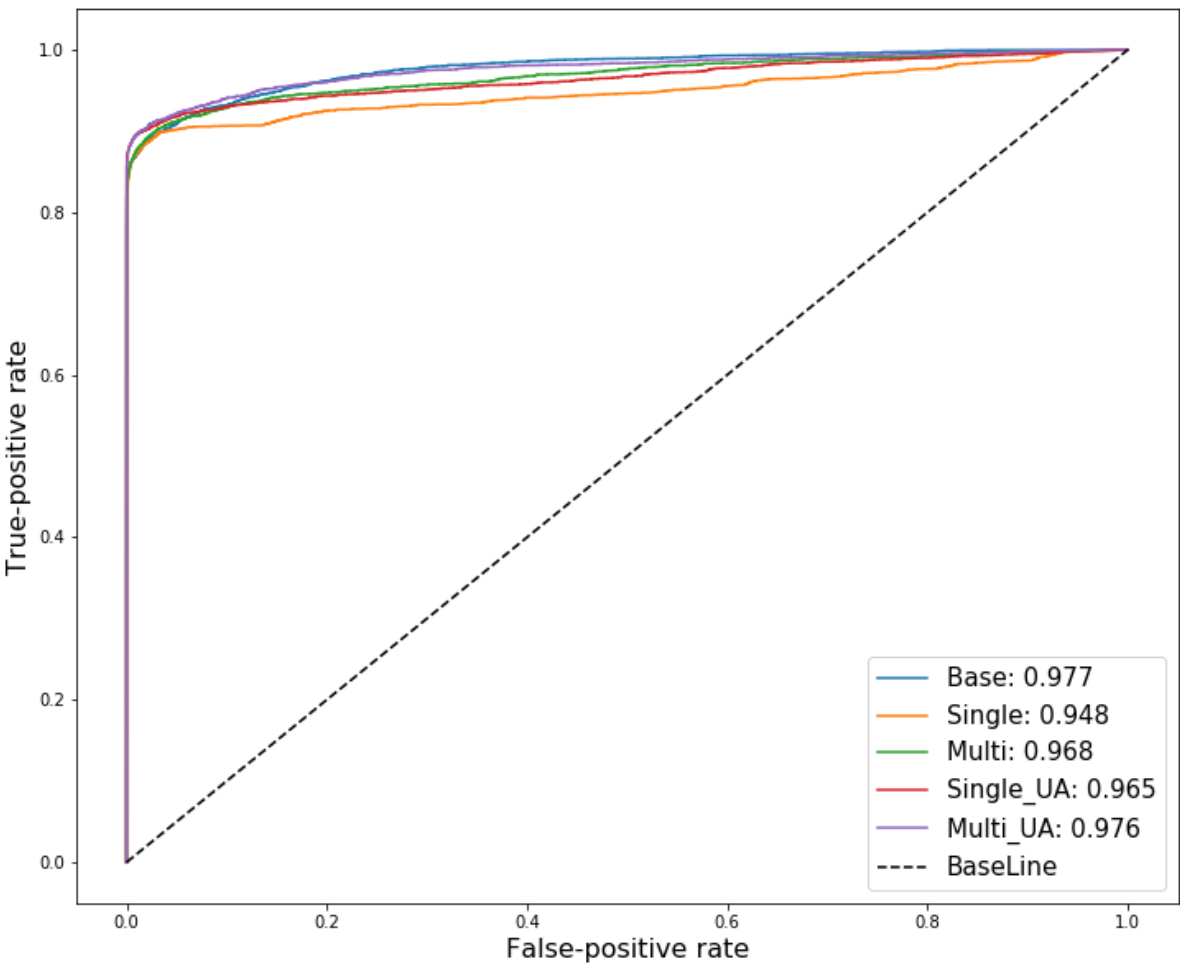
Figure 5. Receiver operating characteristic (ROC) test for the four models. All values estimated from 10 test sets are combined into one set for each model. The base indicates the deep-learning model without attention mechanisms. UA: uncertainty